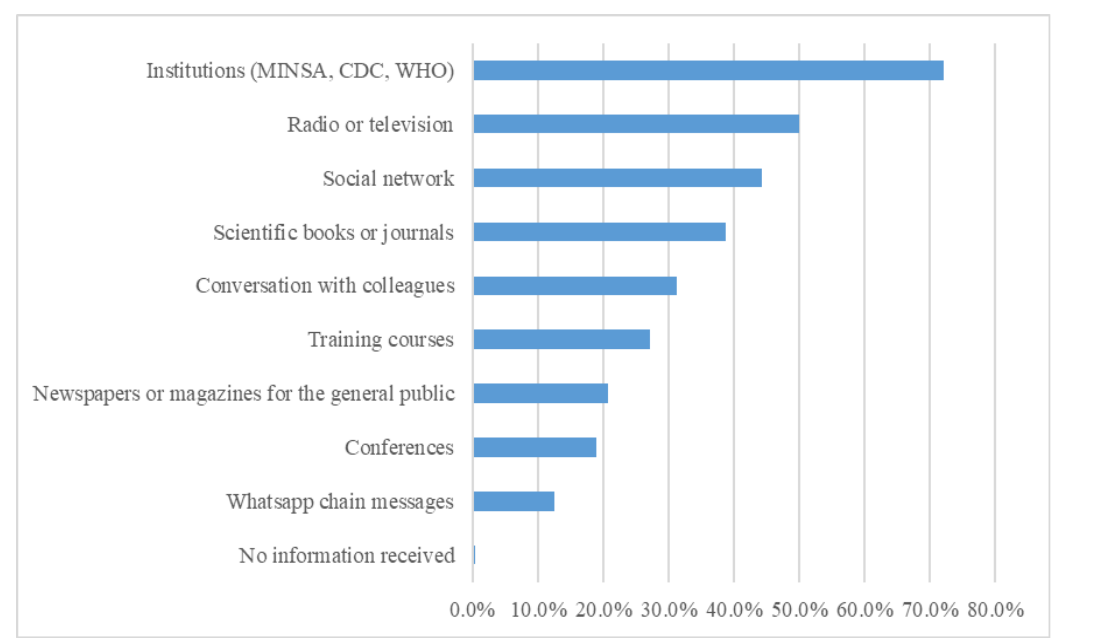
Figure 2. Sources of information on mpox used by Peruvian physicians.